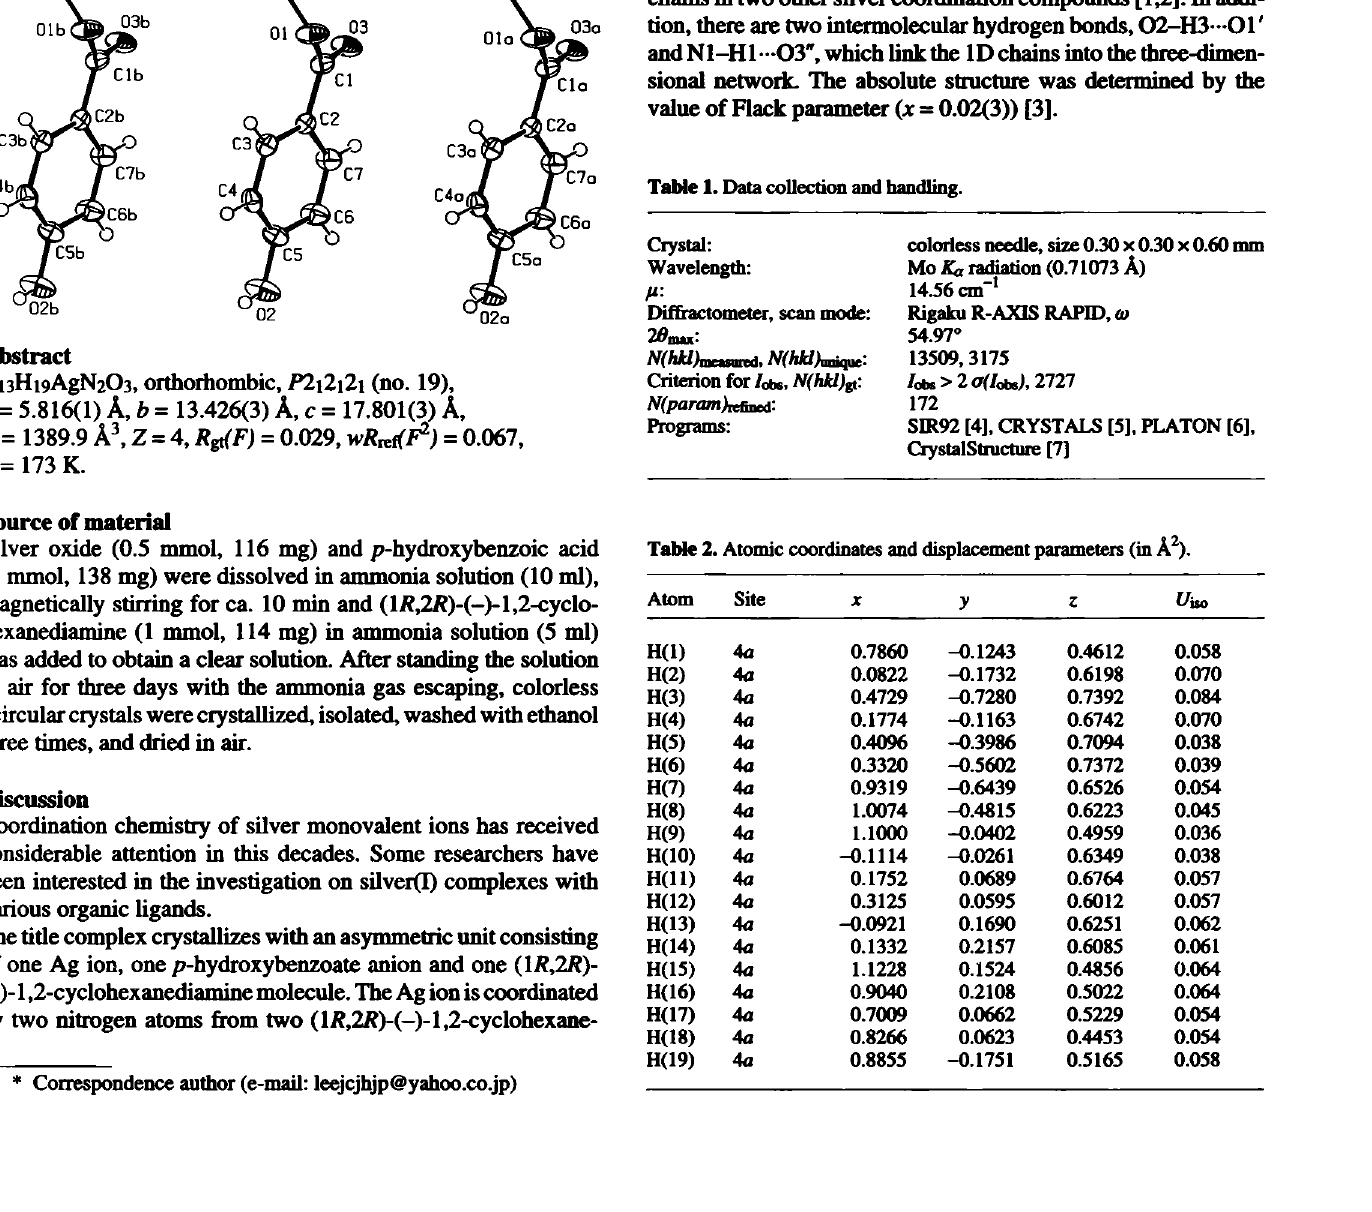
Table 1. Data collection and handling.